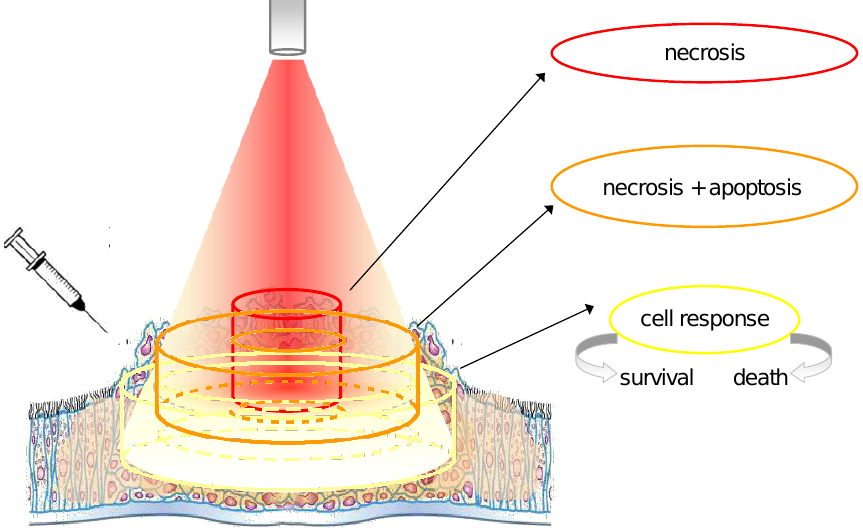
Figure 1. Over-simplified picture of light distribution and cellular responses during